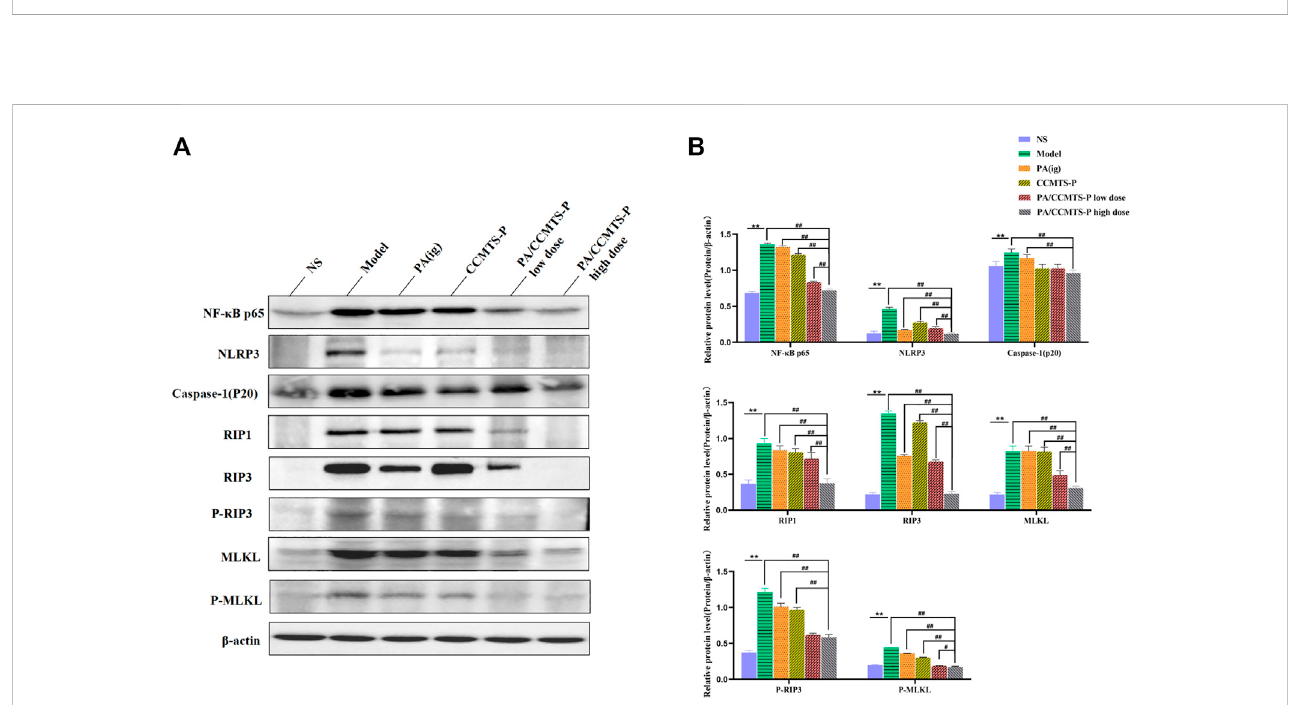
FIGURE 7 PA/CCMTS-P attenuates DSS-induced UC by modulating RIP1/RIP3/MLKL signaling mediated necroptosis and the activation of the NLRP3 in fl ammasome. (A) Western blotting analysis showed that PA/CCMTS-P inhibited the RIP1/RIP3/MLKL necroptosis pathway as well as NF- κ B and NLRP3 in fl ammasome activation in DSS-induced UC mice model. (B) Quantitative analyses of western blotting. Data are shown as mean ± SD ( n = 3 independent experiments), ** p < 0.01; # p < 0.05, ## p <